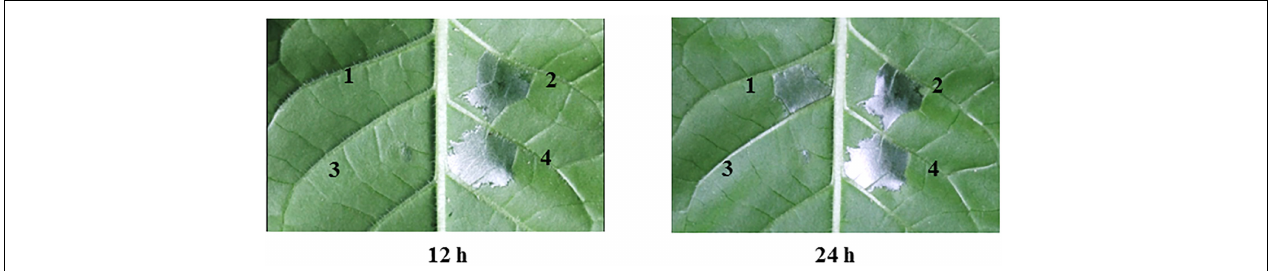
FIGURE 8 | Effect of yggS on the ability of Acidovorax citrulli to induce a hypersensitive response (HR) on Nicotiana tabacum . All strains were cultured in LB overnight and infiltrated into the N. tabacum leaves at a concentration of OD 600 = 0.3. N. tabacum was grown under greenhouse conditions at 24 ◦ C and observed for HR at 12 h and 24 h post infiltration. 1 = yggS deletion mutant (cid:49) yggS , 2 = wild-type strain XjL12, 3 = negative control (NC) = double-distilled H 2 O (ddH 2 O), 4 = complemented strain C yggS .